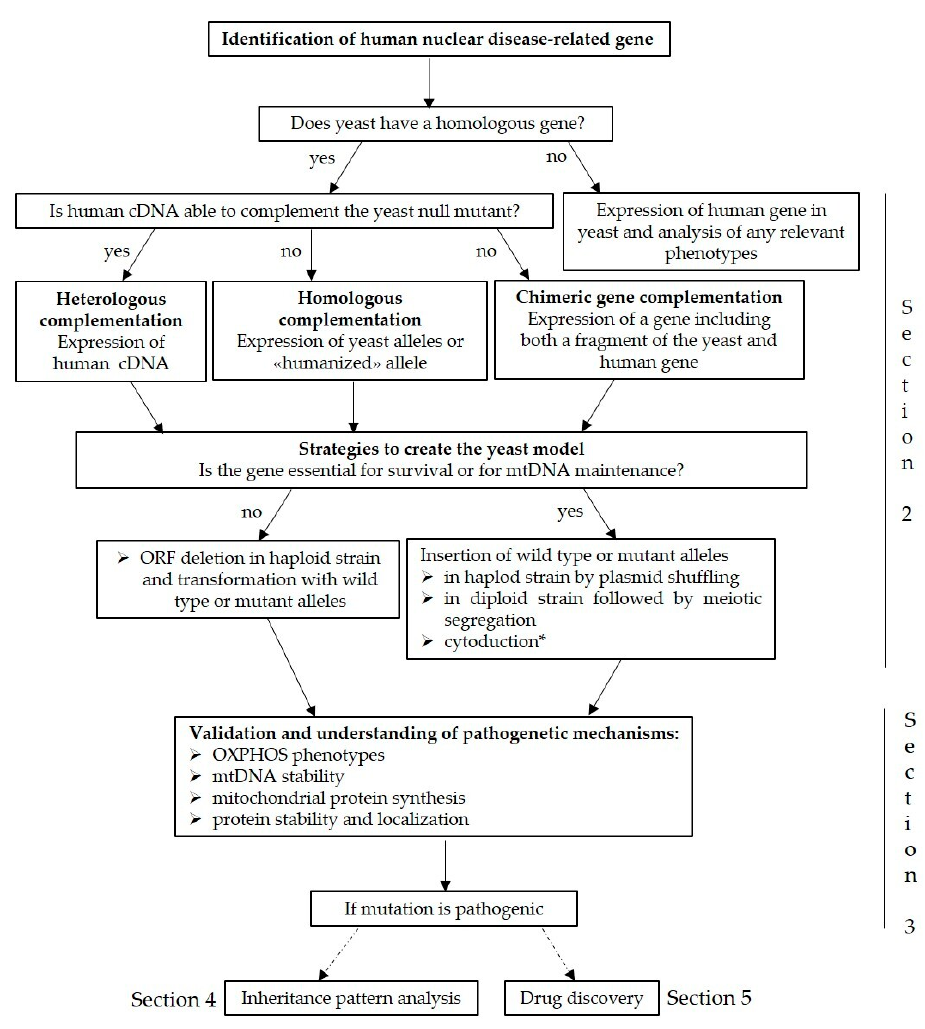
Figure 1. Workflow for the creation of the yeast models of mitochondrial diseases. * cytoduction is a strategy only used in case the gene is essential for mitochondrial DNA (mtDNA) maintenance. cDNA, complementary DNA; ORF, open reading frame; OXPHOS, oxidative phosphorylation.